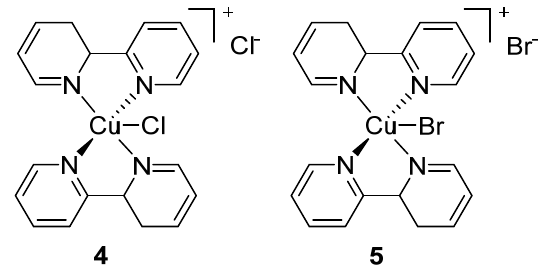
Cl]Cl·6H O ( 4 ) [35] and [Cu(bpy) 2 2